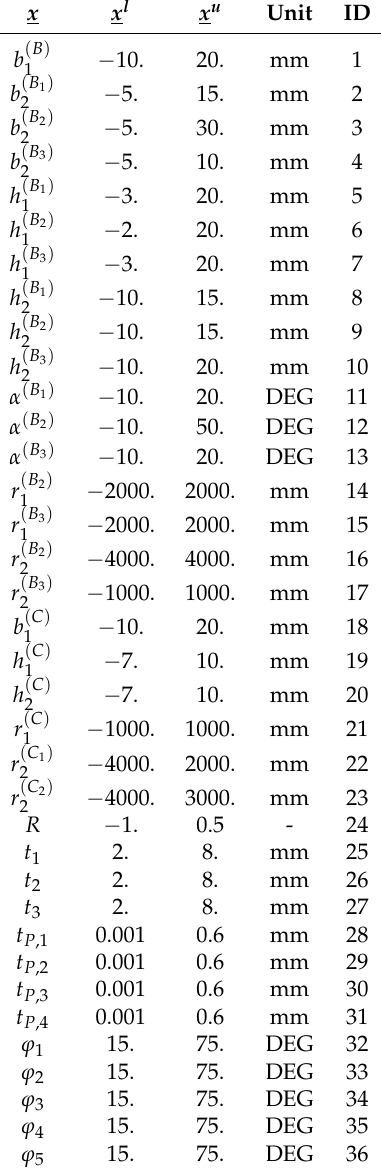
Table A1. Definition of the design space - the shape variables of the